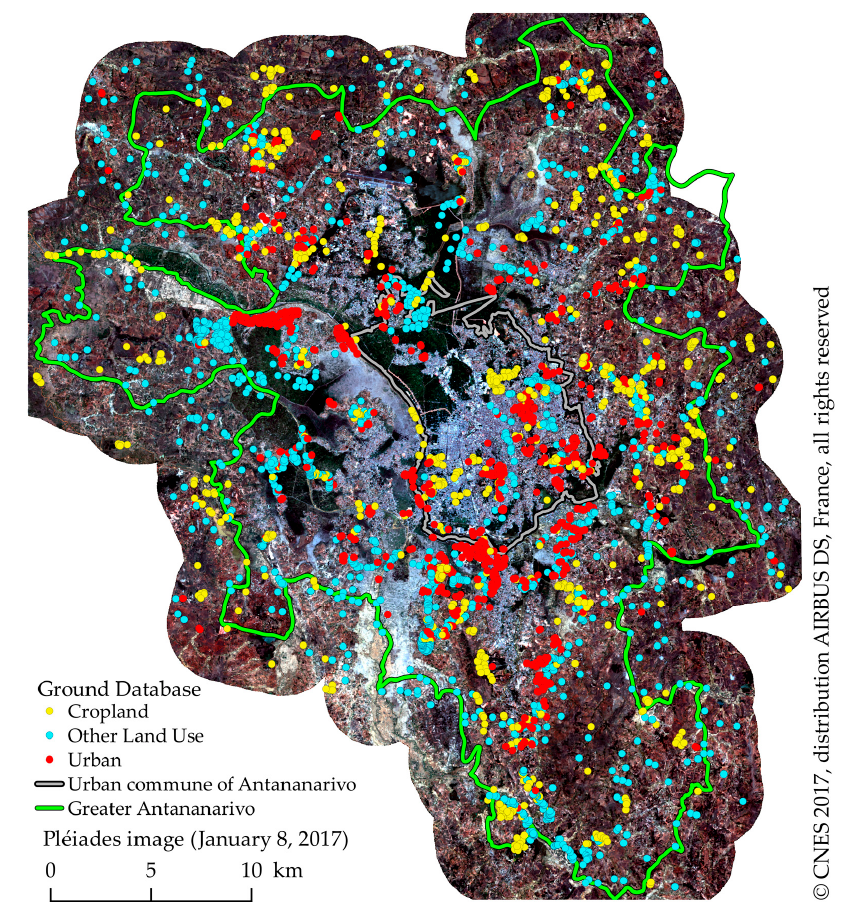
Figure 3. Distribution of the collected waypoints (background image: Pleiades image acquired on January 8, 2017).